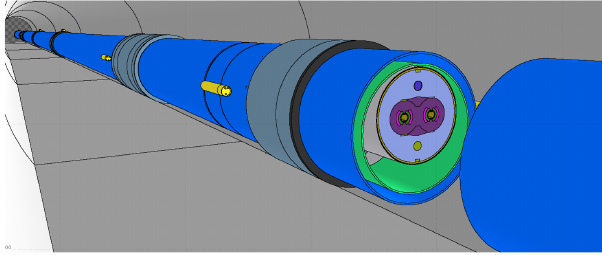
FIG. 3. Geometry model of a LHC arc cell used in the particle shower simulations. The picture shows the vicinity of a quadru- pole. The cryostat and dipole next to the quadrupole are cut open to show the interior. The beam loss monitors of the quadrupole (yellow cylinders) are mounted on the outside of the